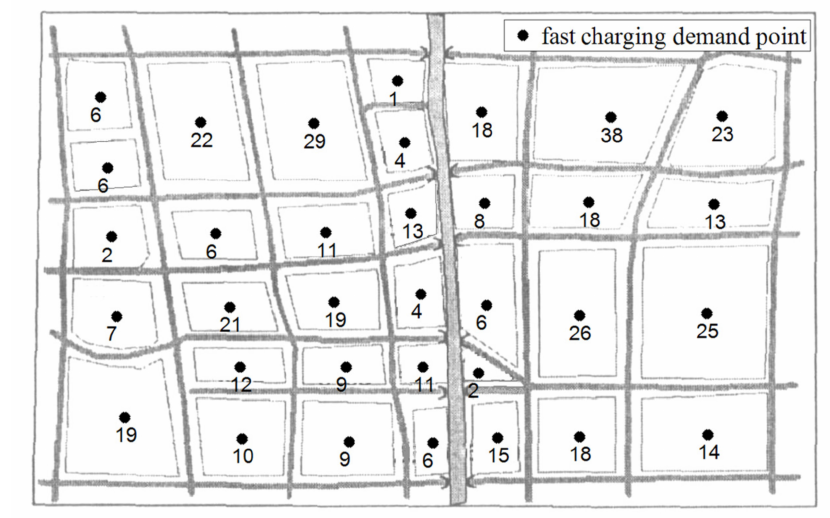
Figure 3. Distribution of EVs with fast charging